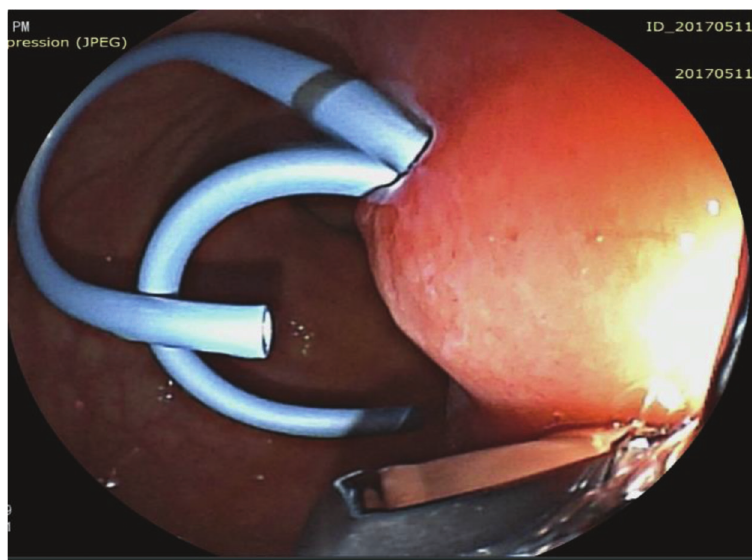
Figure 4 - Placement of two double-pigtail stents (10 Fr or 8.5 Fr) to drain the pancreatic